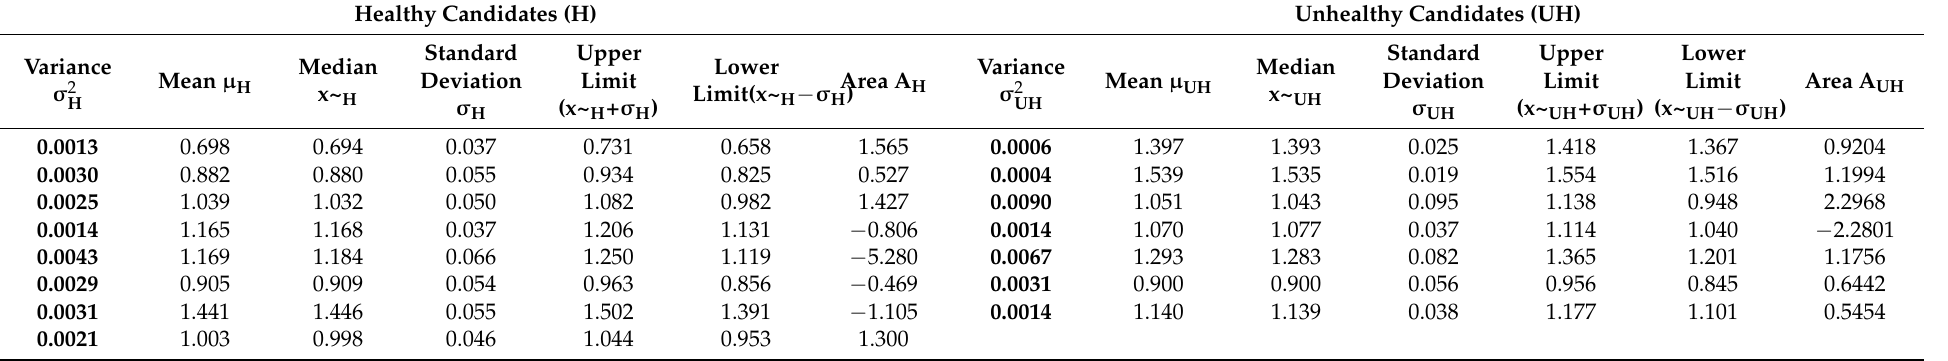
Table 5. Statistical analysis outcome for the combination of parameters JT interval, RR interval, and QRS interval.